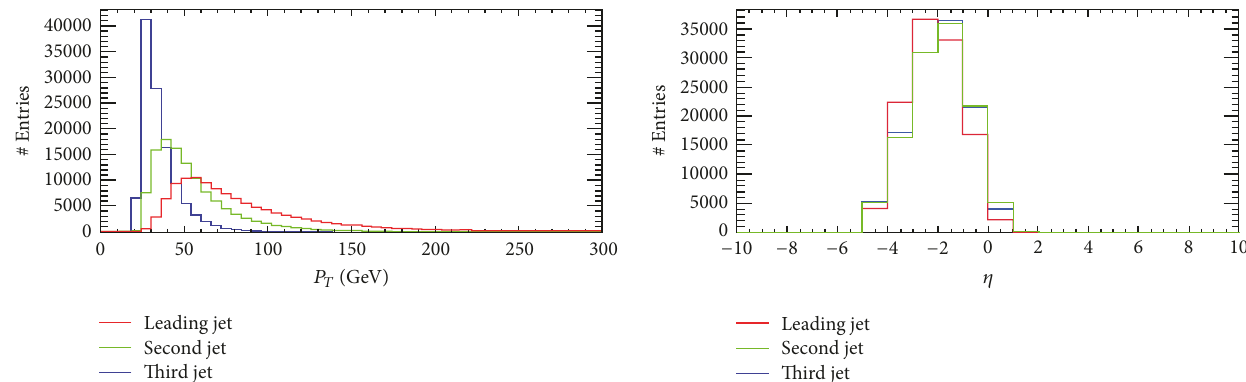
Figure 3: Transverse momentum and pseudo-rapidity distributions of three jets from the process 𝑒 − 𝑝 → 𝑒 − 𝑊 ± 𝑞 + 𝑋 which includes both the interfering background and signal for 𝜆 𝑢 = 𝜆 𝑐 = 0.05 at the LHeC.